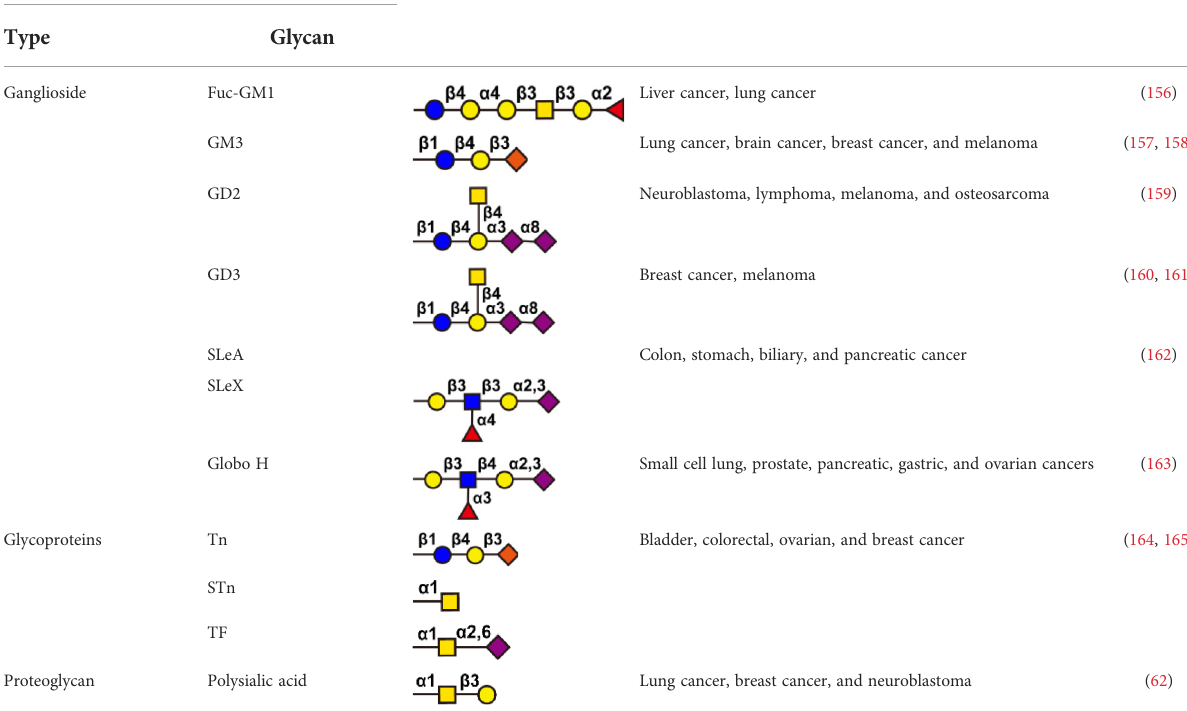
TABLE 4 Representative polysaccharide vaccine in tumor immunotherapy. Tumor-associated polysaccharide vaccines